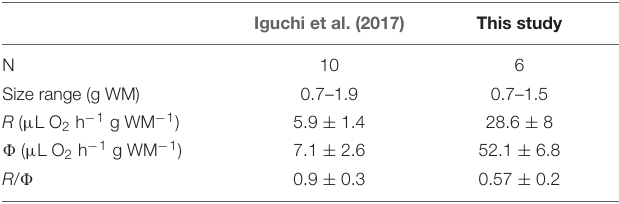
TABLE 6 | Comparison between ETS results (mean ± SD) on A. aurita medusae from Iguchi et al. (2017) and from our study. Iguchi et al. (2017)